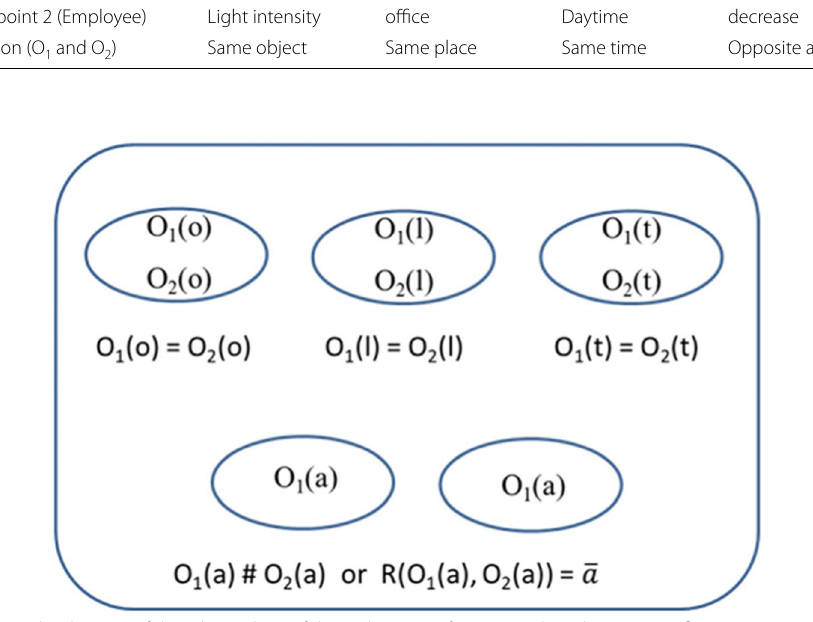
Fig. 5 The diagram of the relationships of three elements of two OSs when there is a conflict situation between two